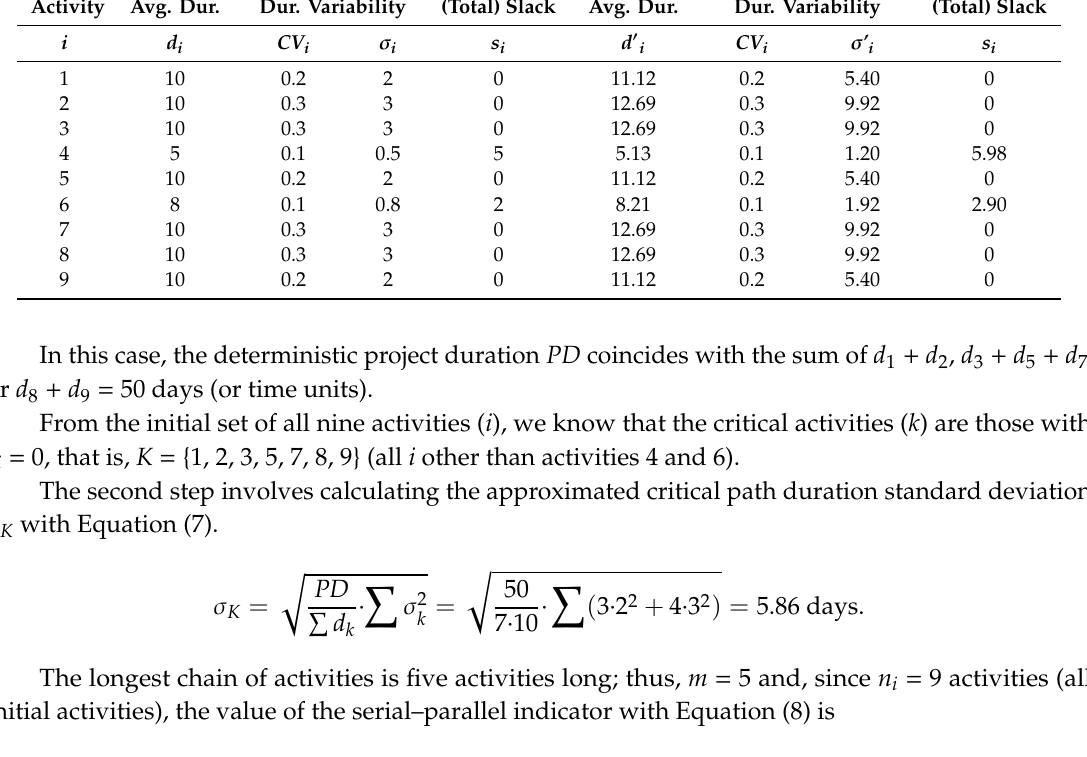
Table 1. Project network example: deterministic schedule information. Avg.—average; Dur.—duration. Normally Distributed Activity Duration